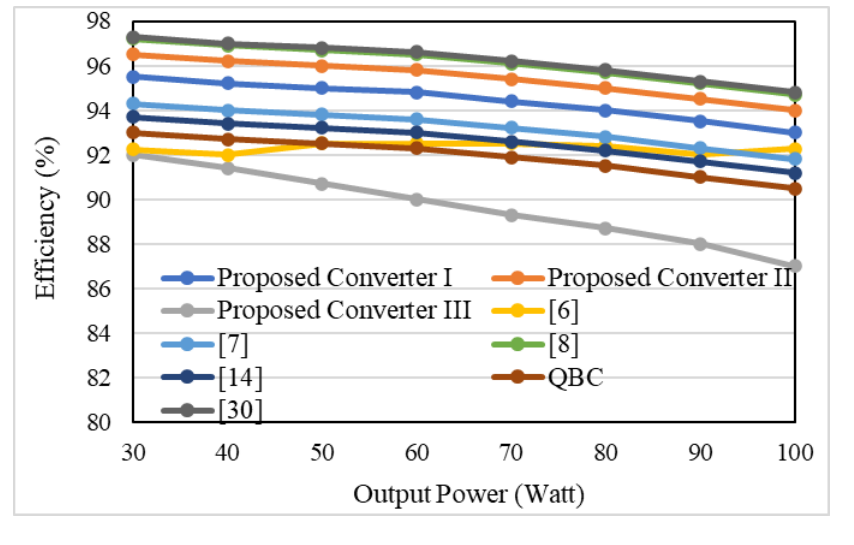
Figure 12. Efficiency vs. output power curve.